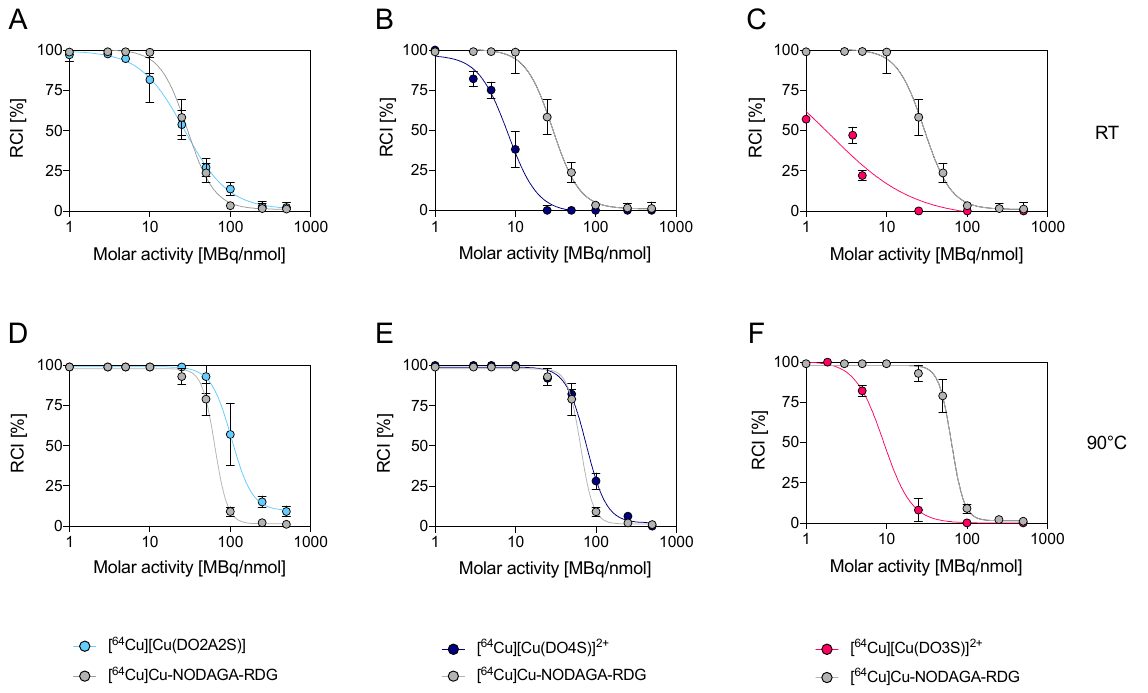
Figure 2. [ 64 Cu]Cu 2+ incorporation yields (10 min, pH 4.5) at different molar activities for DO2A2S, DO4S and DO3S. ( A – C ): RT ( D – F ): 90 °C. Incorporations are compared with those obtained with NODAGA-RDG under the same conditions.